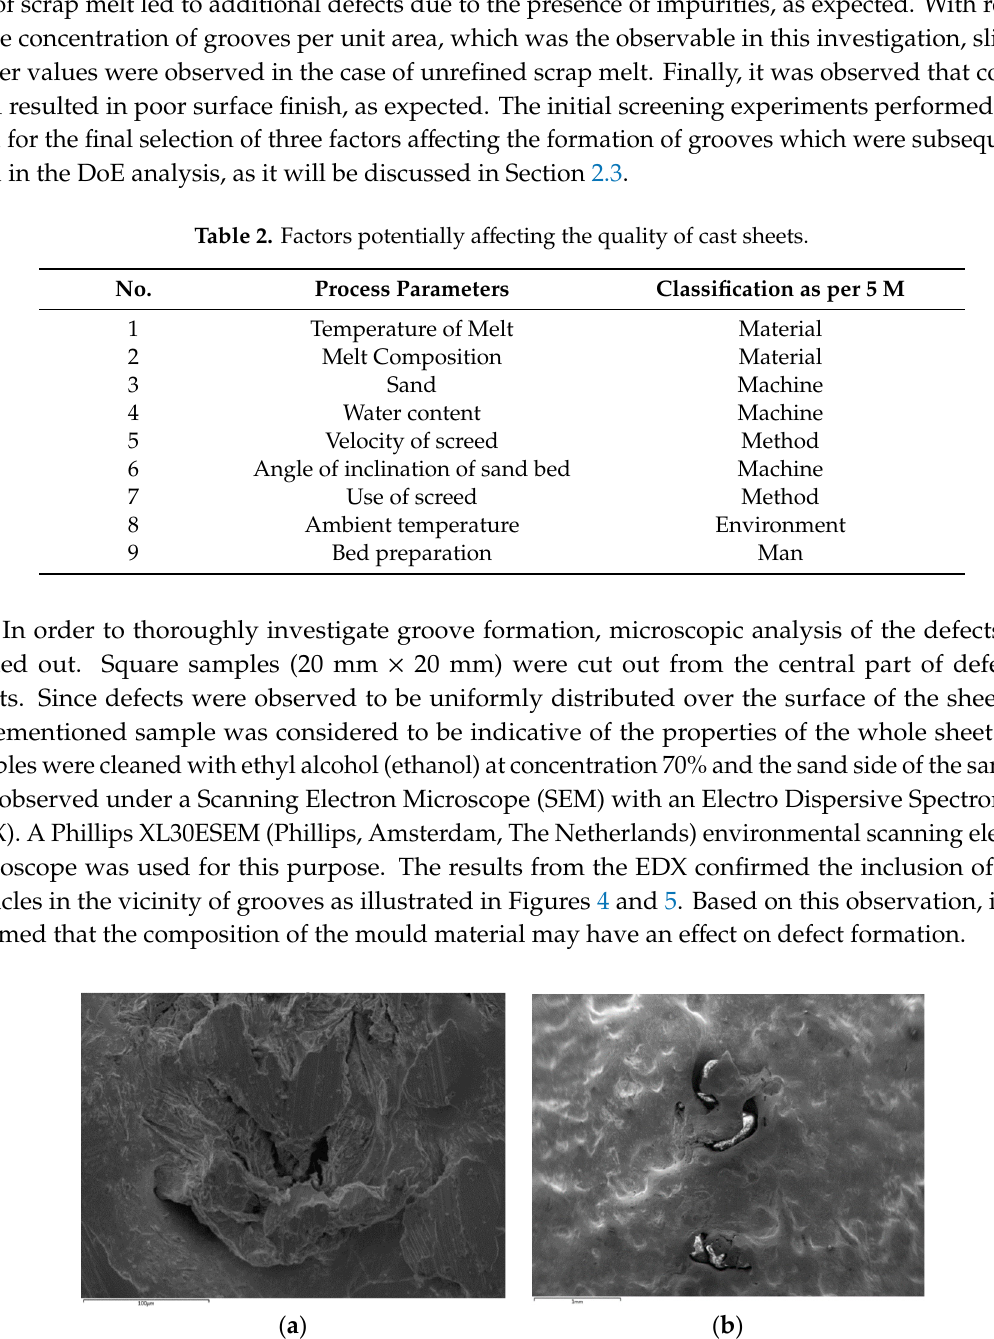
Table 2. Factors potentially affecting the quality of cast sheets.